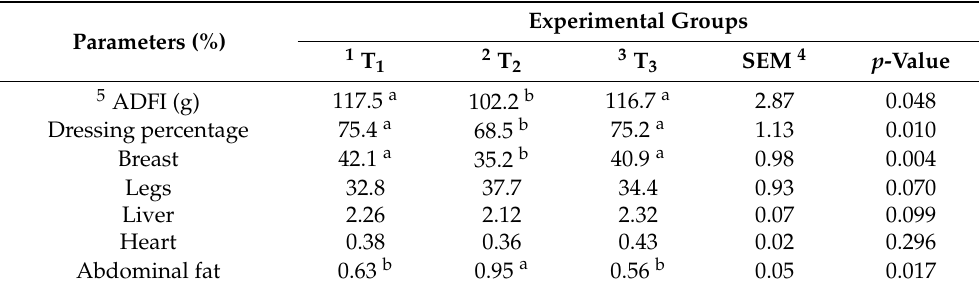
Table 2. Effect of dietary curcumin supplementation on feed intake and carcass traits of heat-stressed broiler